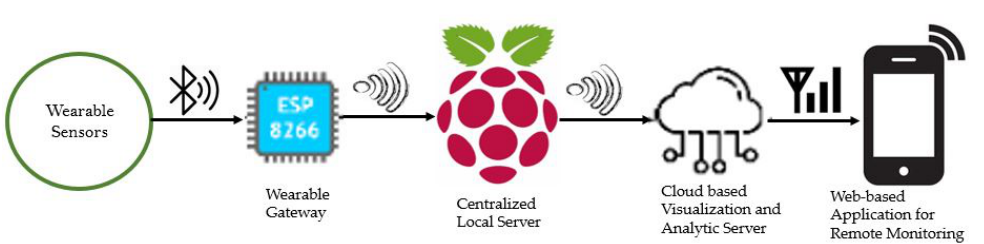
Figure 1. Overview of the proposed WIoT based framework for Geo-fencing and remote monitoring of COVID-19 susceptible and